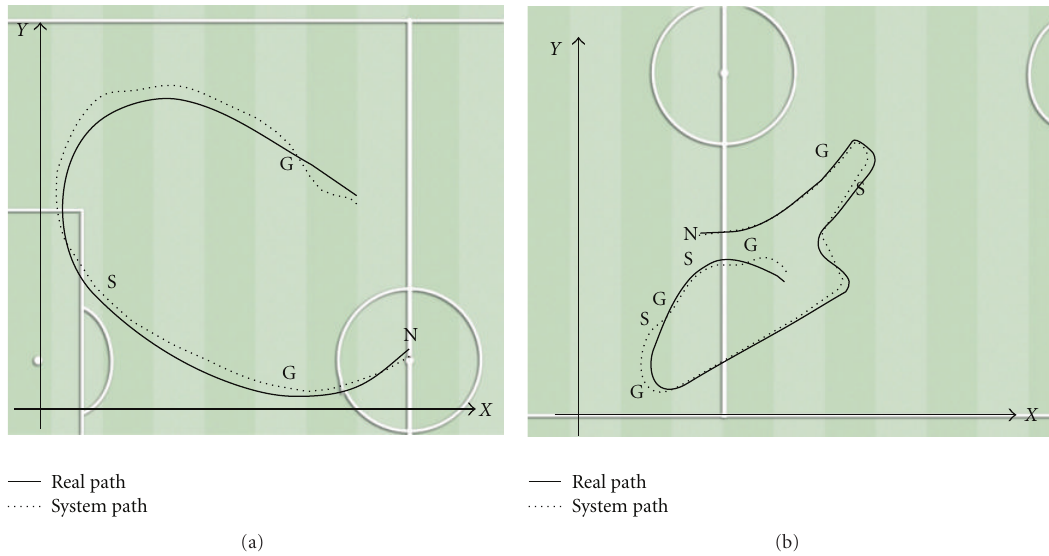
Figure 20: Comparing real and system path of two players. The events new (N), merging (G), and splitting (S) are shown on the path.